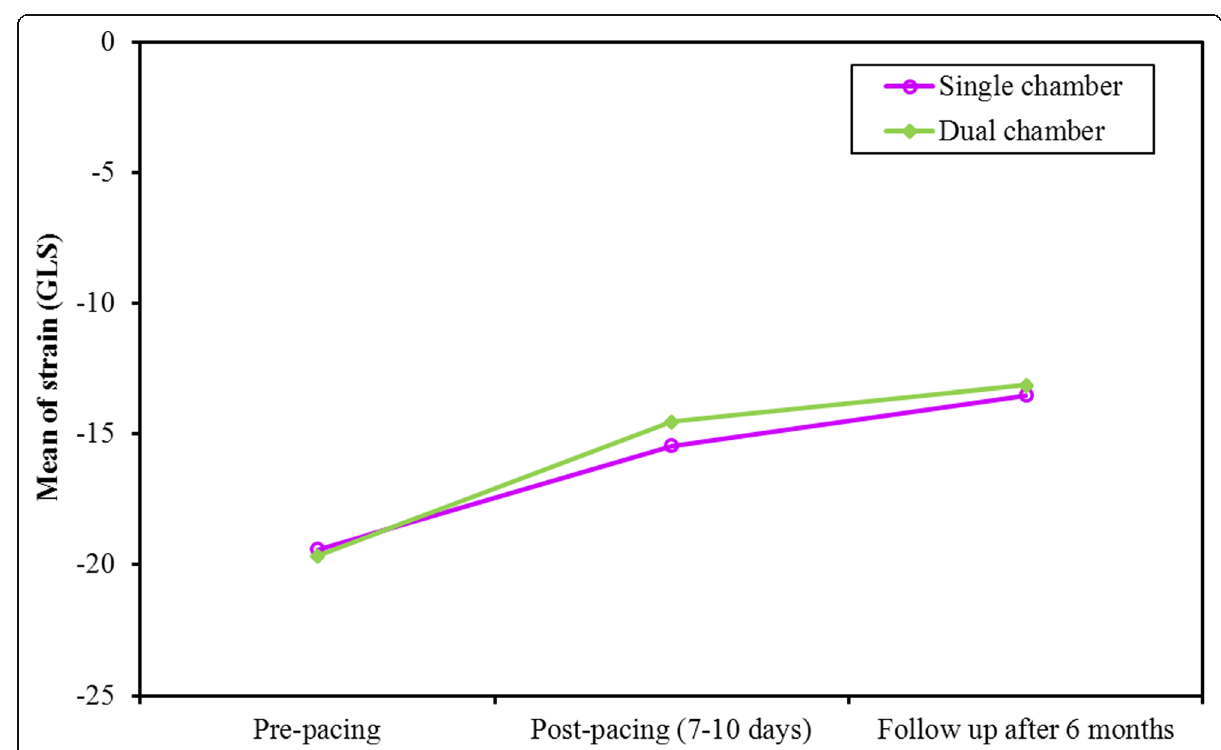
Fig. 7 Comparison between the different periods according to strain (GLS) in each